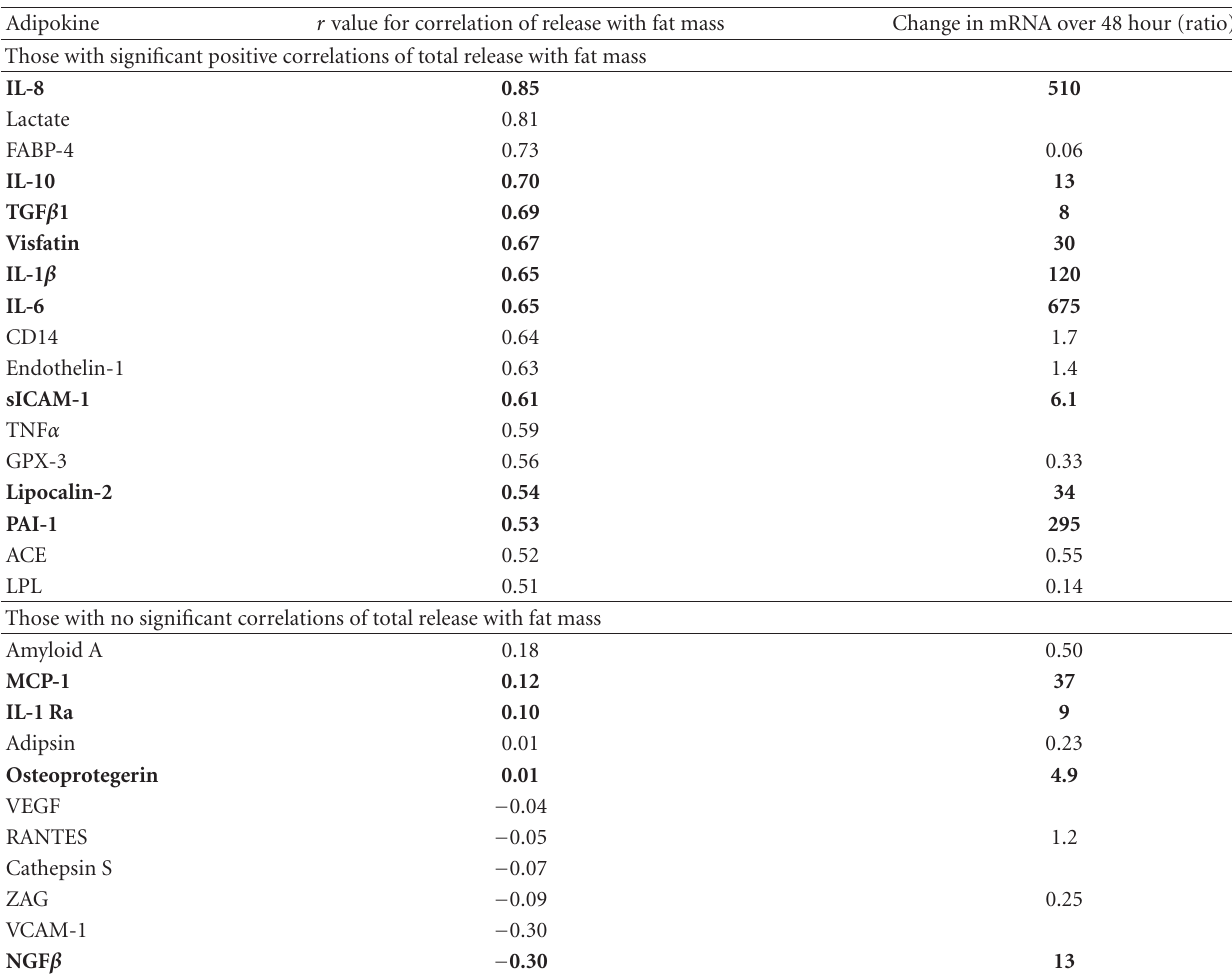
Table 3: Correlation between total release by explants of human fat and total fat mass as well as the change in mRNA over 48 hours